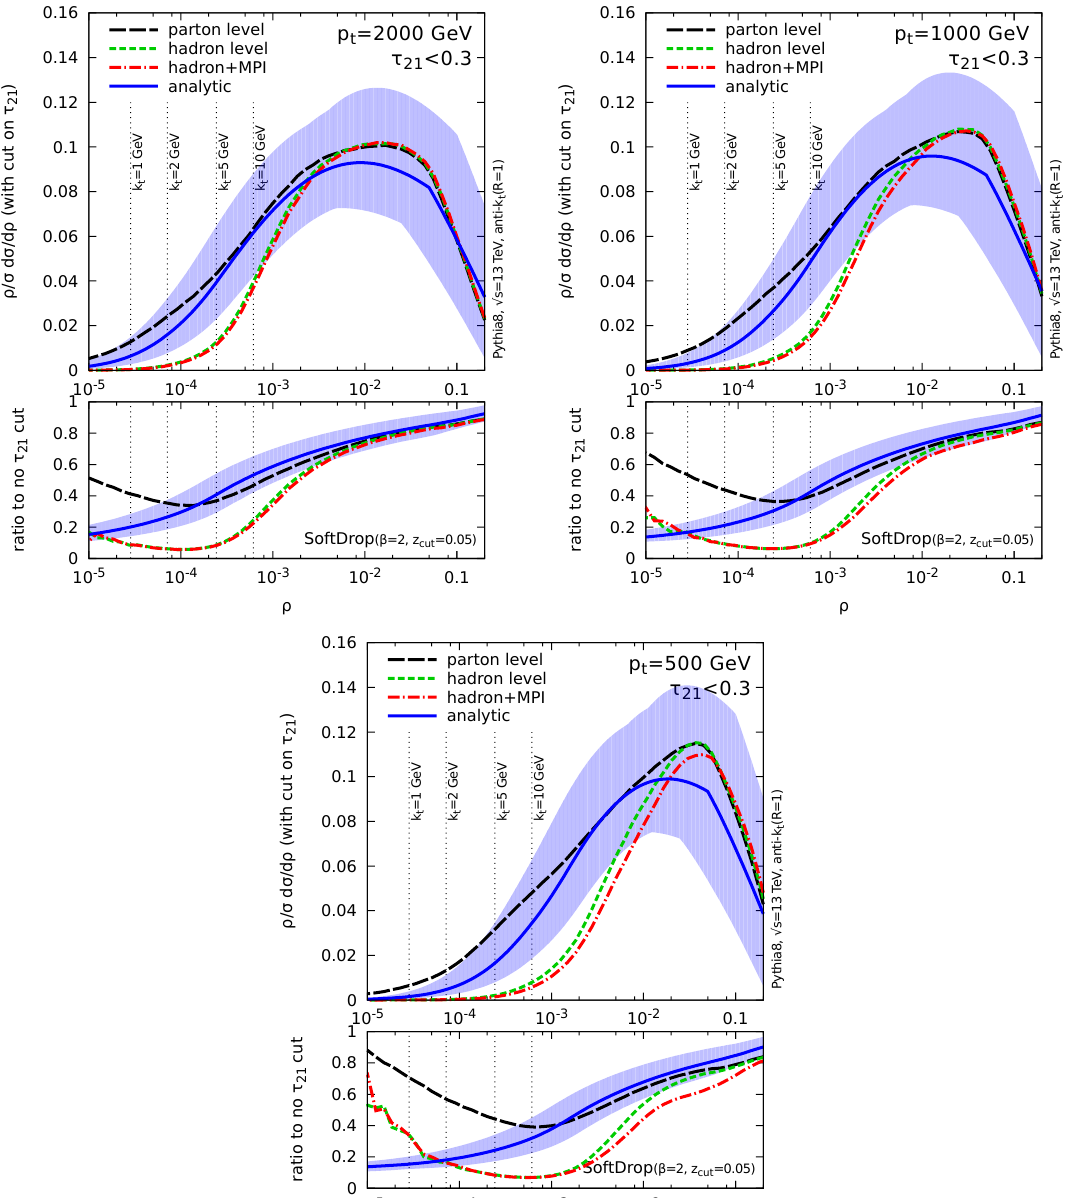
Figure 9 . Same as (cid:12)gure 7 now for di(cid:11)erent values of p t . Here we show results for the Pythia8 generator at di(cid:11)erent levels in order to gauge the importance of non-perturbative e(cid:11)ects. All the plots use a representative cut on (cid:28) 21 of